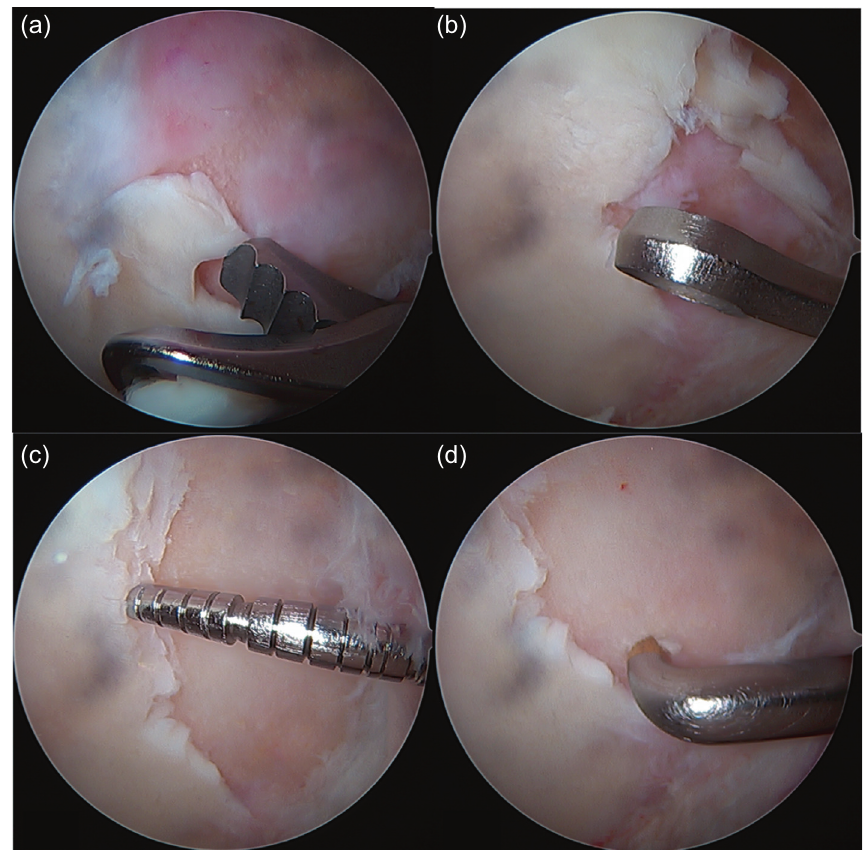
Figure 2. Treatment of the full-thickness focal chondral lesion: (a) Resection of the unstable chondral tissue is performed in the first instance with either shaver or tissue resection. (b) The unstable edges of the lesion are then resected with a ringed curette, leaving the edge as stable and vertical as possible; also the calcareous layer of the exposed subchondral bone is removed with the curettes. (c) After this procedure, it is recommended to palpate the edges of the lesion to confirm the stability of the remaining tissue as well as to measure the chondral defect in millimetric scale. (d) The microfractures are then made with an arthroscopic awl beginning at the vertex of the lesion. For this purpose, there are awls of different angulation to make the perforations as vertical as possible to the